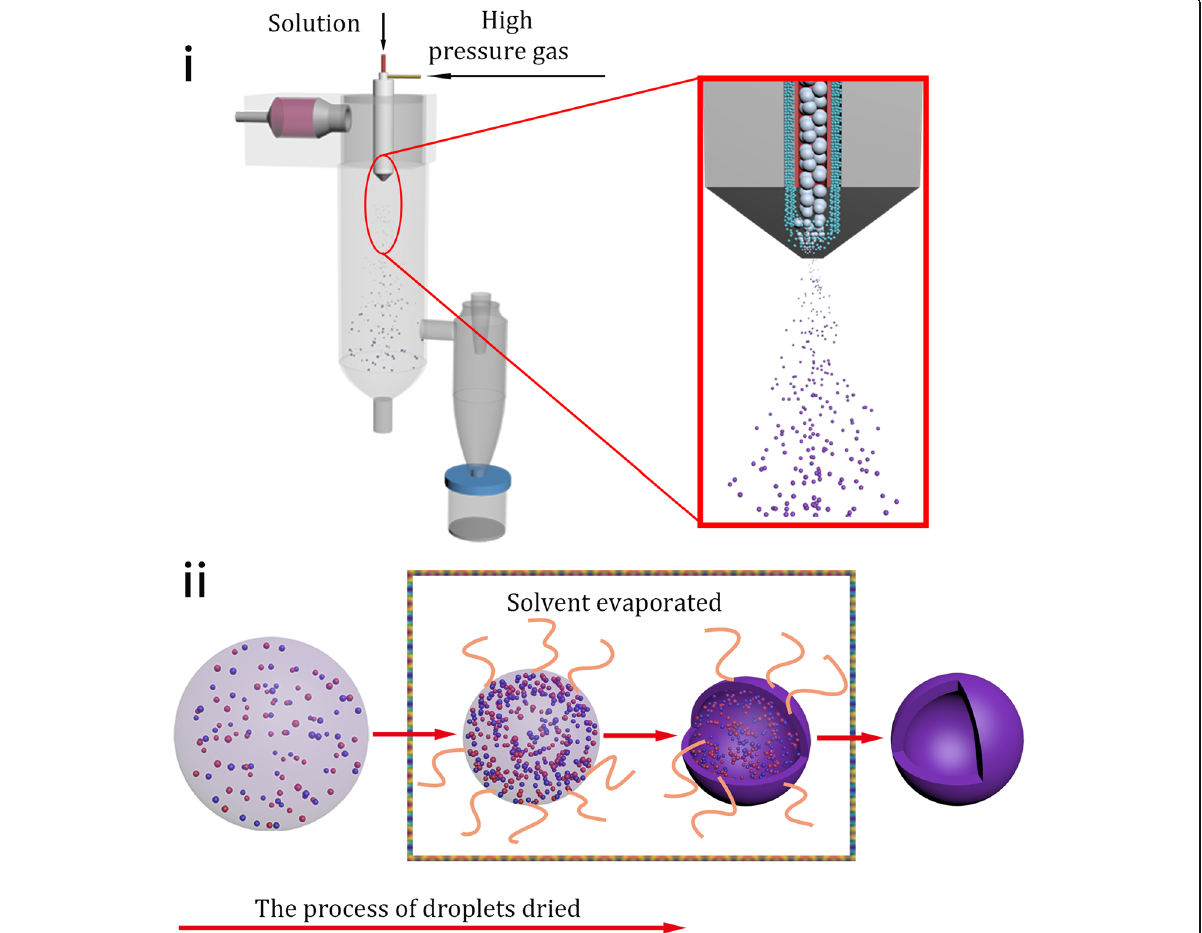
Fig. 2 The schematic of spray drying process. i The detailed schematic of formed process of particles. ii The specific process of transformation of